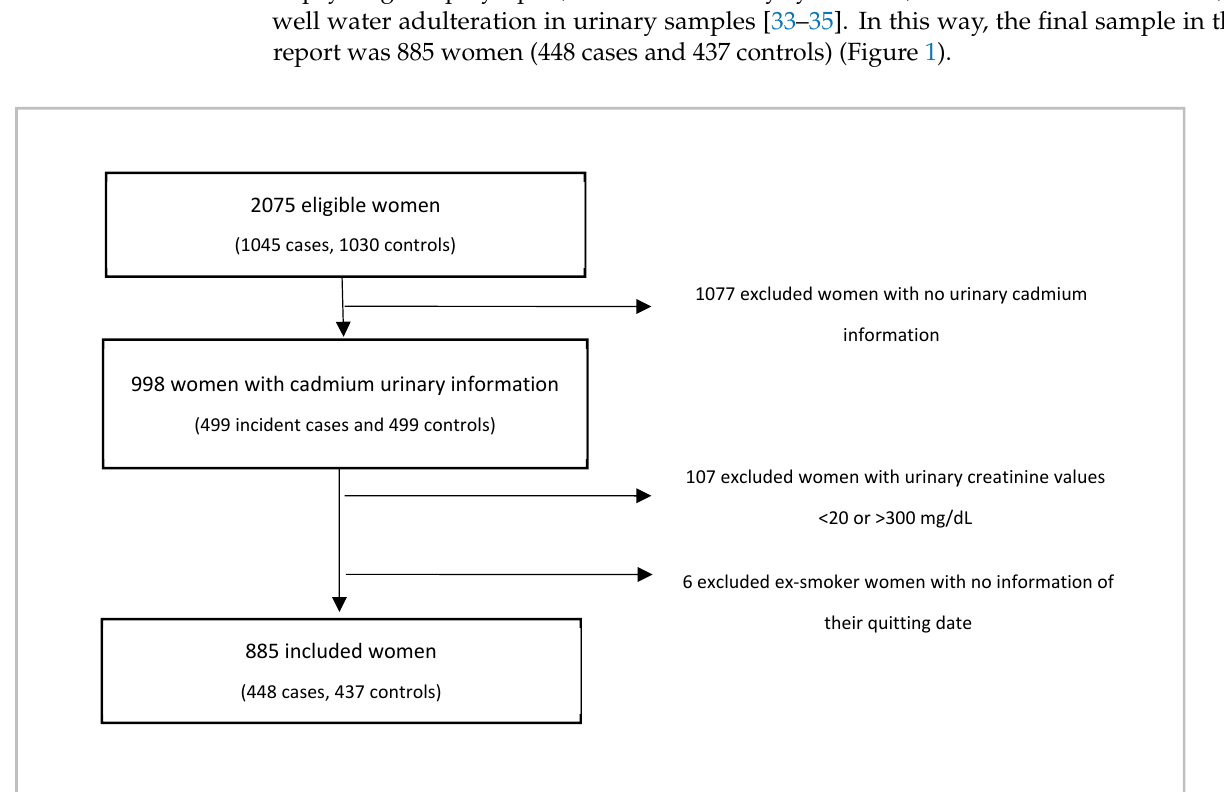
Figure 1. Selection of sample studied in this report.